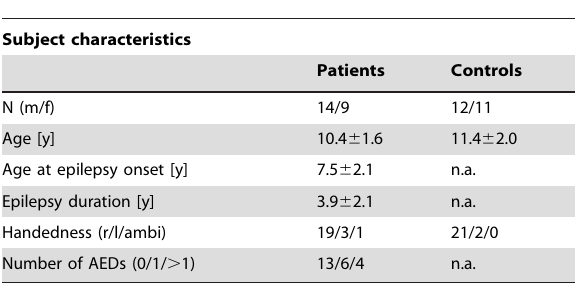
Table 1. Subject characteristics, if applicable mean 6